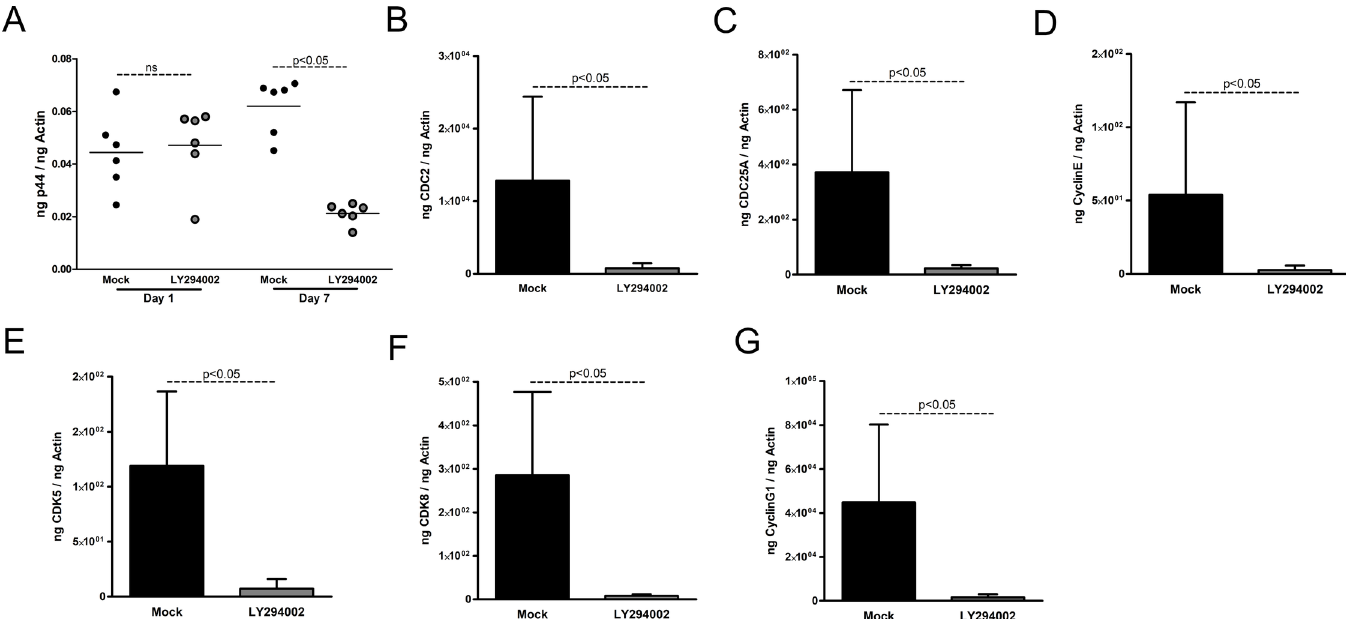
Fig 4. Inhibition of PI3 kinases reduces expression of cell cycle genes and A . phagocytophilum burden in MEG-01 cells. ( A) QRT-PCR analysis showingbacterialburdenin A . phagocytophilum -infected mock (DMSO-treated) or LY294002(PI3K inhibitor)-treated MEG-01 cells at days 1 and 7 p.i. The A . phagocytophilum specific p44 DNA loads were normalized to humanbeta-actin levels. Each circle representsone individualsample. QRT-PCR analysis showinglevels of CDC2 (B), CD25A (C), cyclin E (D), CDK5 (E), CDK8 (F) and cyclin G1 (G) in A . phagocytophilum -infected mock or LY294002(PI3K inhibitor)-treated MEG-01 cells at day 7 p.i. QRT-PCR was performed on samples generatedfrom three independentexperiments (3 samples/experiment) and analyzedin duplicates. The levels of cell cycle genes were normalized to human beta-actin. The P value (P < 0.05)calculatedfrom Student’s t test was consideredsignificant.